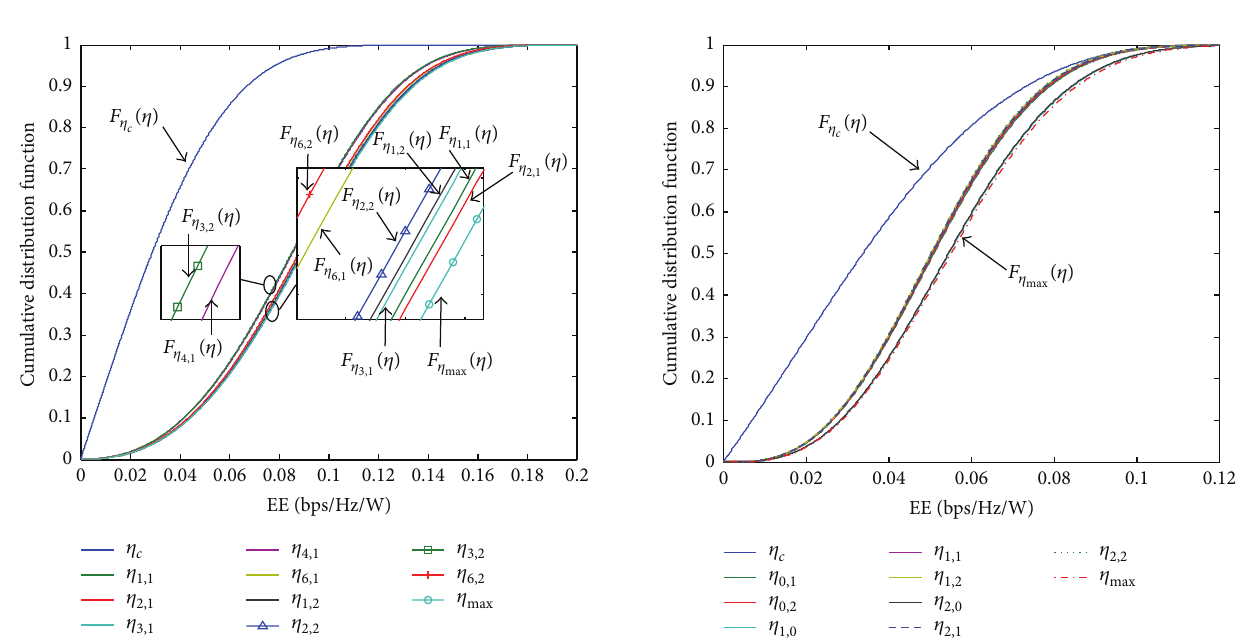
Figure 6: EE distributions for CS-DAS with CoAU-2 transmission scenario and traditional cellular structure.